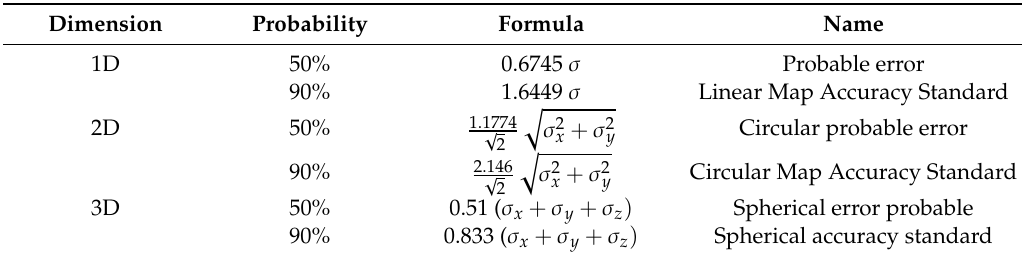
Table 6. Errors for 50% and 90% confidence